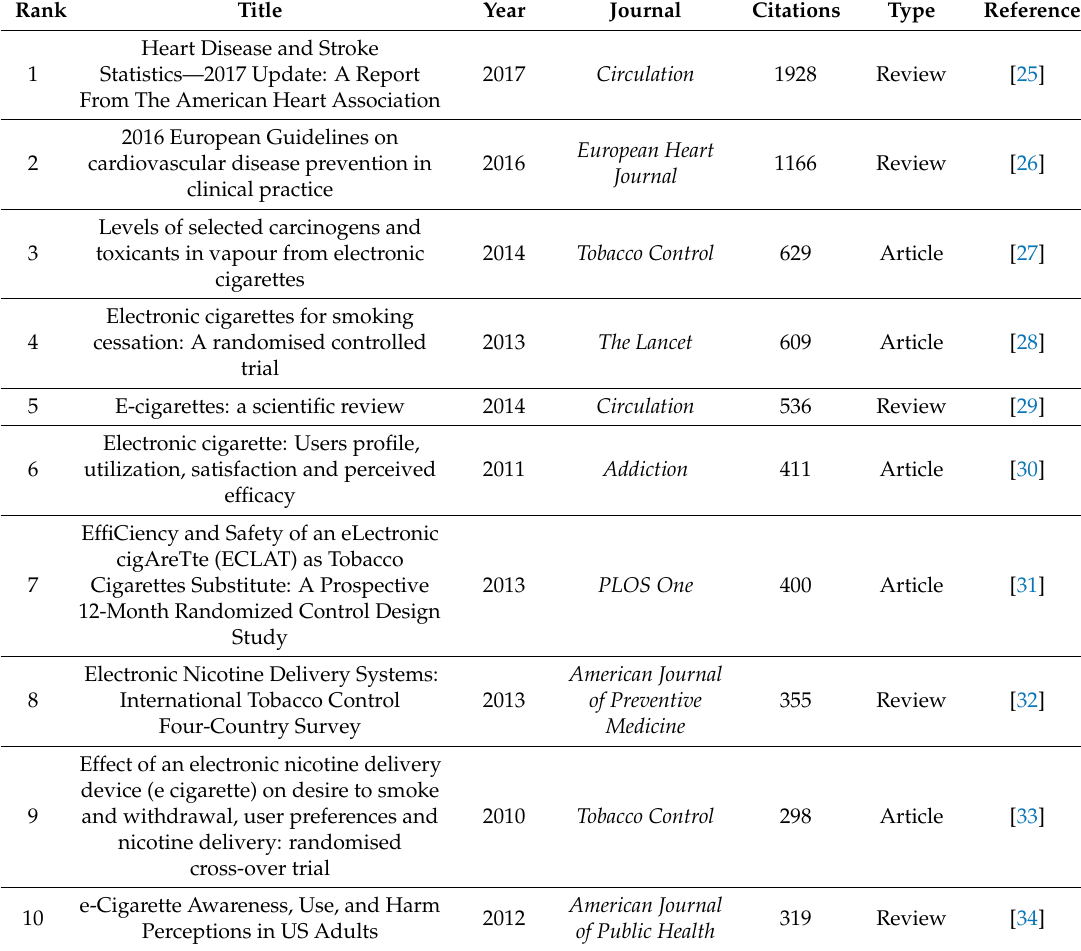
Table 1. Top 10 electronic cigarette articles from 2003 to